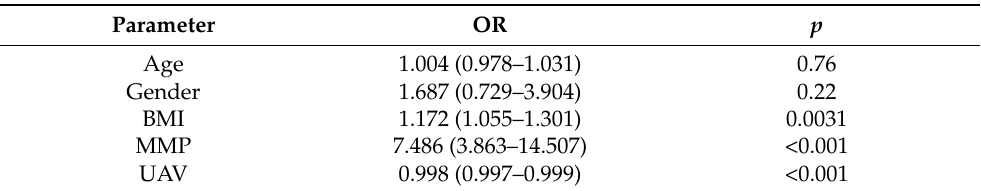
Table 2. Values of the variables included in the analysis depending on the answer to the question “Do you snore?” in the Berlin